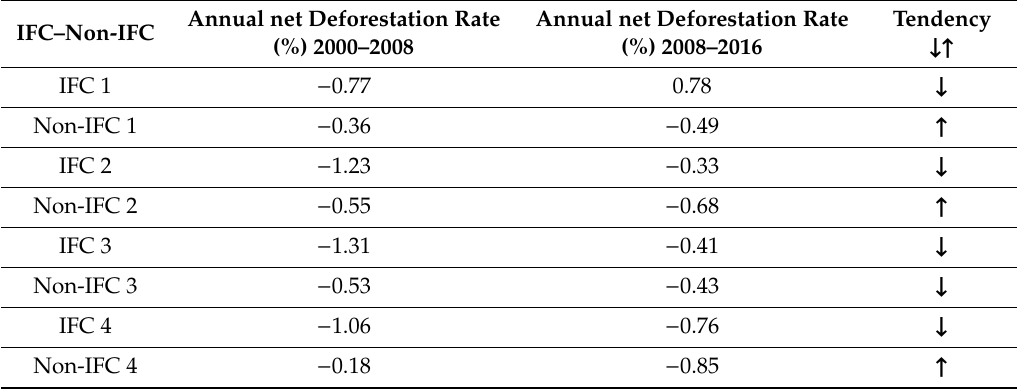
Table A8. Annual rate of deforestation at a parish level for areas influence by IFC and Non-IFC between 2000–2008 and